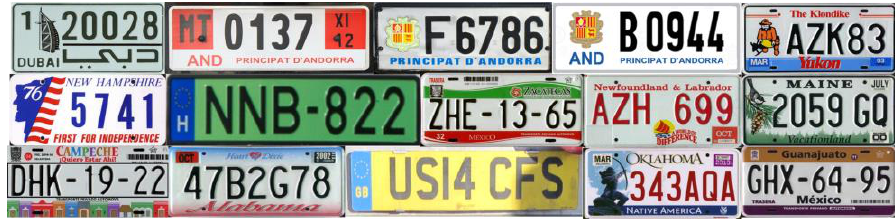
Figure 1. Multinational vehicles license plates.